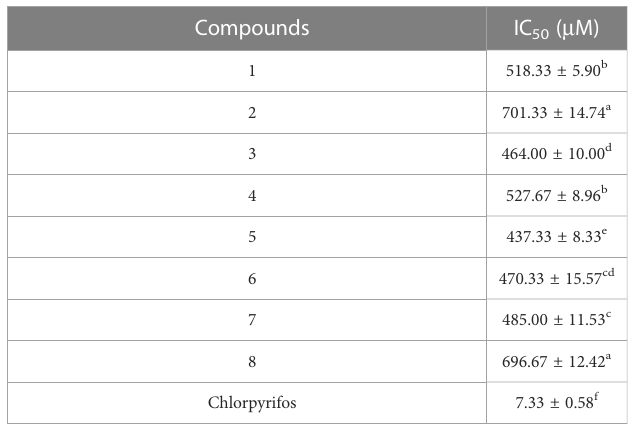
TABLE 2 IC 50 of AChE inhibition by